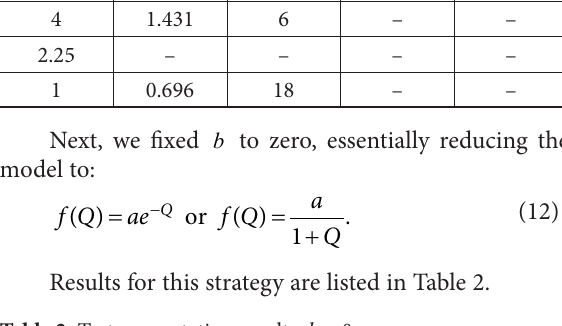
Table 2. Test computation results, b =